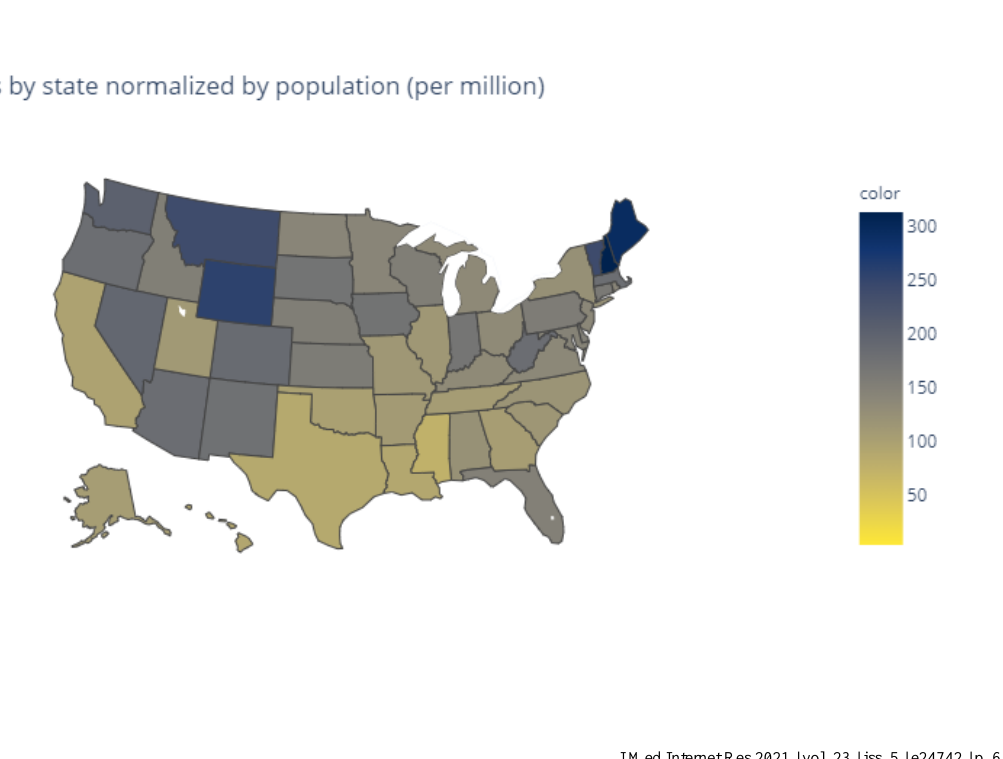
Figure 3. Total responses by US state normalized by population. Lighter colors indicate low counts, whereas darker colors indicate a higher number of